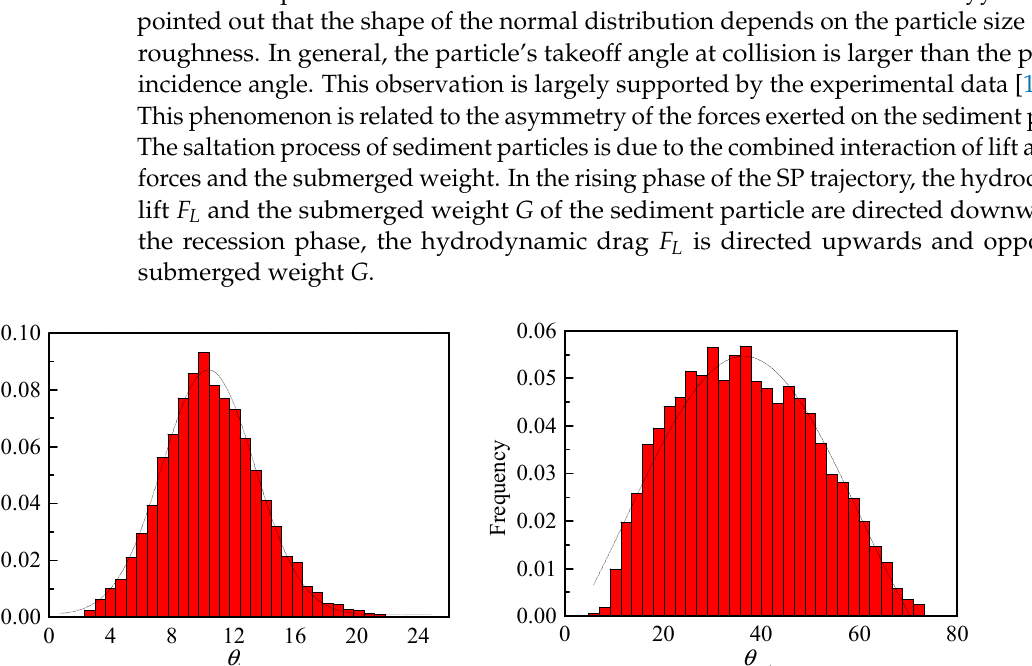
Figure 14. Frequency distributions of incidence angle θ in and takeoff angle θ out . ( a ) Incidence angle. ( b ) Takeoff angle.